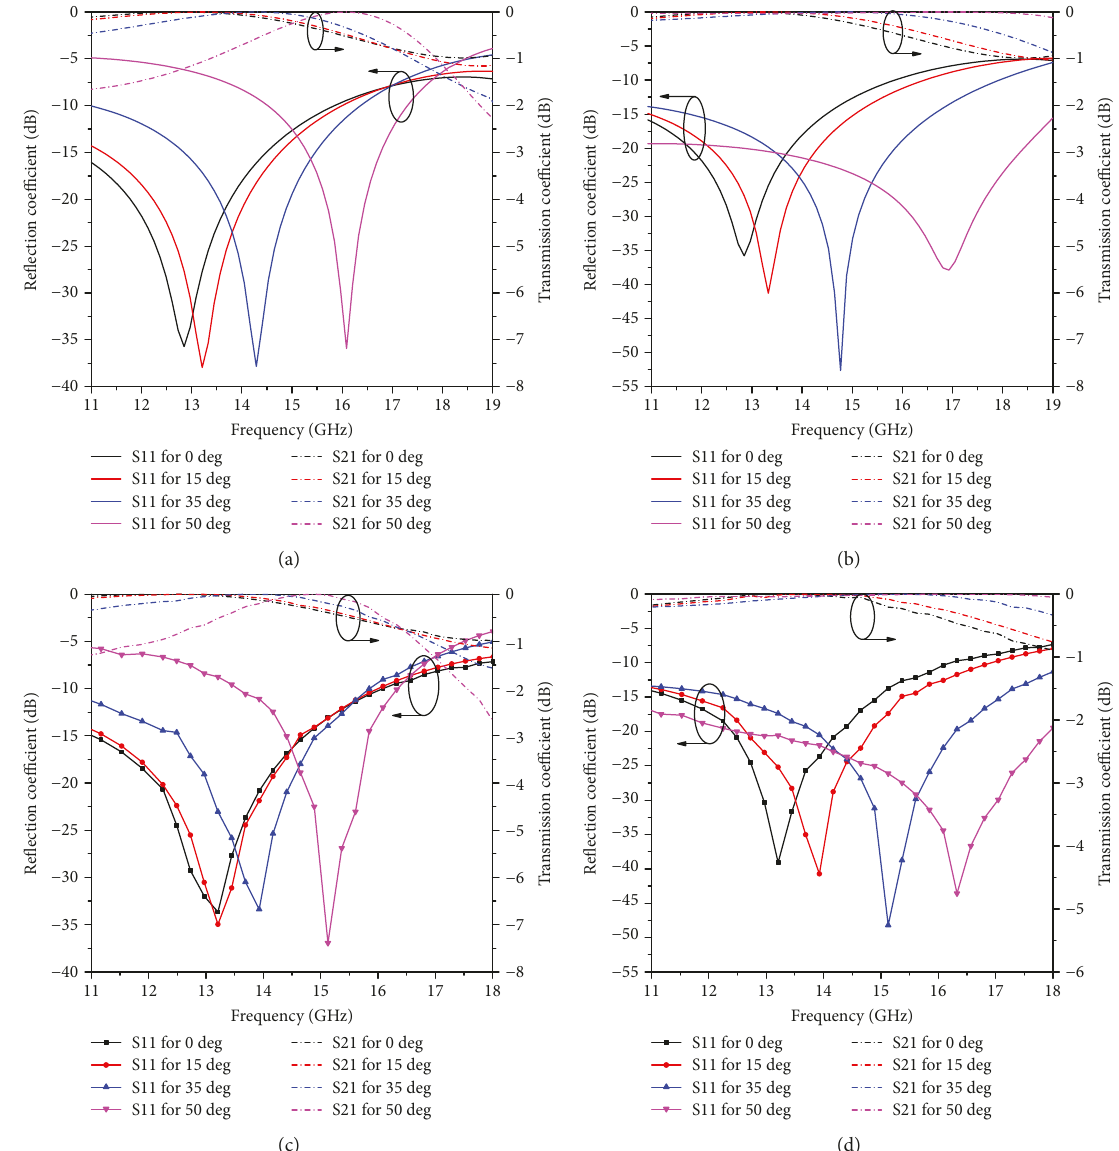
Figure 7: Simulated (a, b) and experimental (c, d) transmission and re fl ection coe ffi cient results for oblique incidences of 0, 15, 35, and 50 degrees in (a, c) x-z and (b, d) y-z planes.